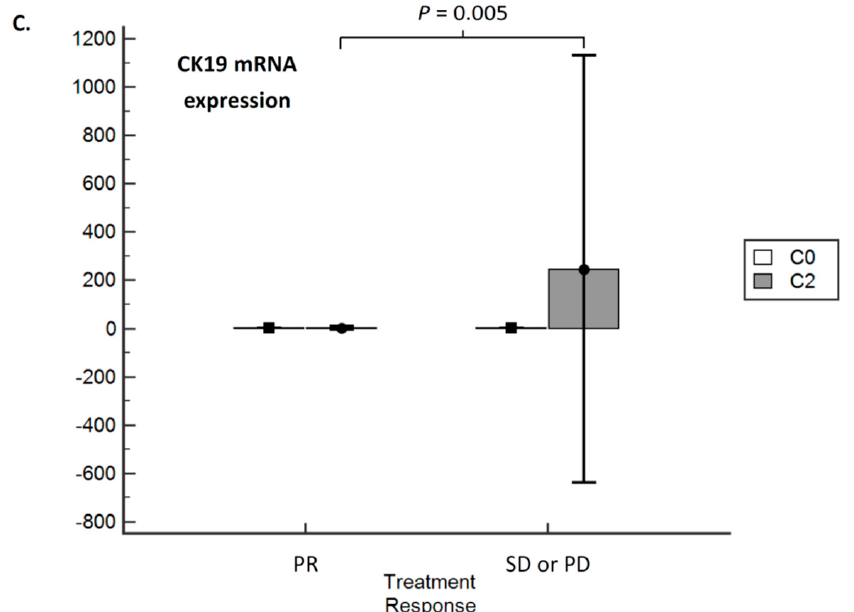
Figure 2. Bar graph with horizontal lines and marks for mean ± standard deviation demonstrated plasma mRNA expression change of ( A ) astrocyte-elevated gene-1 (AEG-1), ( B ) thymidylate synthase (TS), and ( C ) CK19 in non-small cell lung cancer (NSCLC) patients before chemotherapy (C0) and after two cycles of chemotherapy (C2). Patients with stable disease (SD) or progressive disease (PD) had significant increased plasma mRNA expression of AEG-1, TS and CK19, compared to those with partial response (PR) after two cycles of chemotherapy.